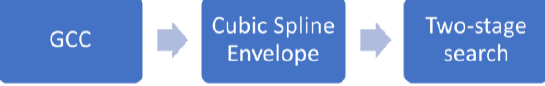
Figure 12. Robust Mutual Ranging Algorithm flow chart.